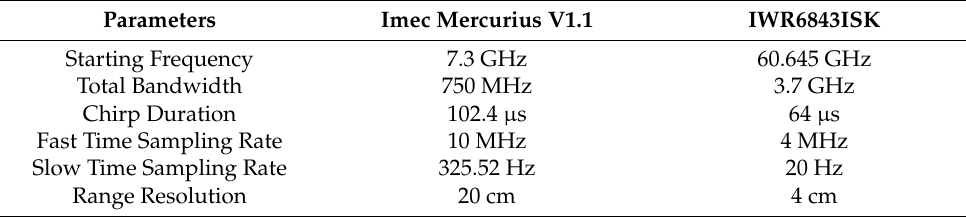
Table 1. Radar parameters. Parameters Starting